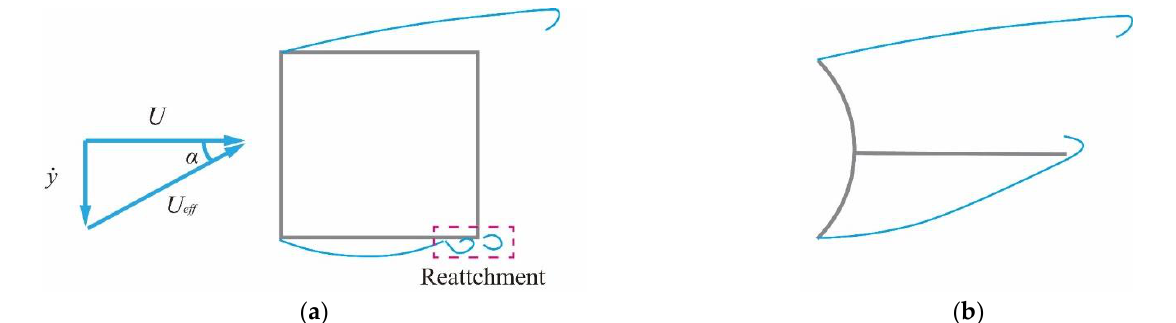
Figure 14. The schematic of flow separation for ( a ) square cross-section and ( b ) arc-plate-shaped cross-section.